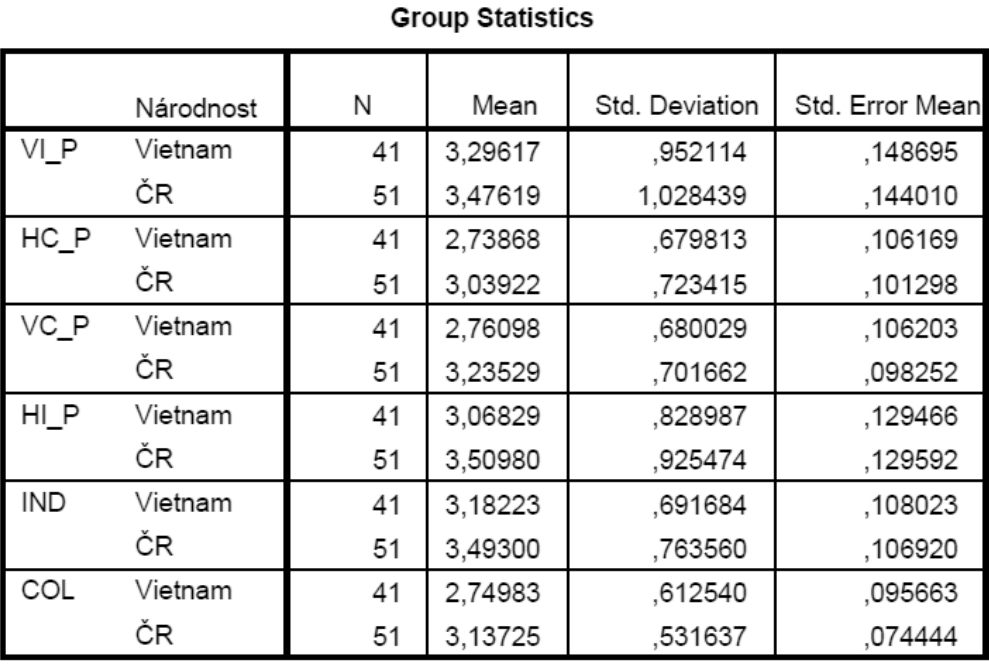
Table 5: Group statistics for Czechs and Czech